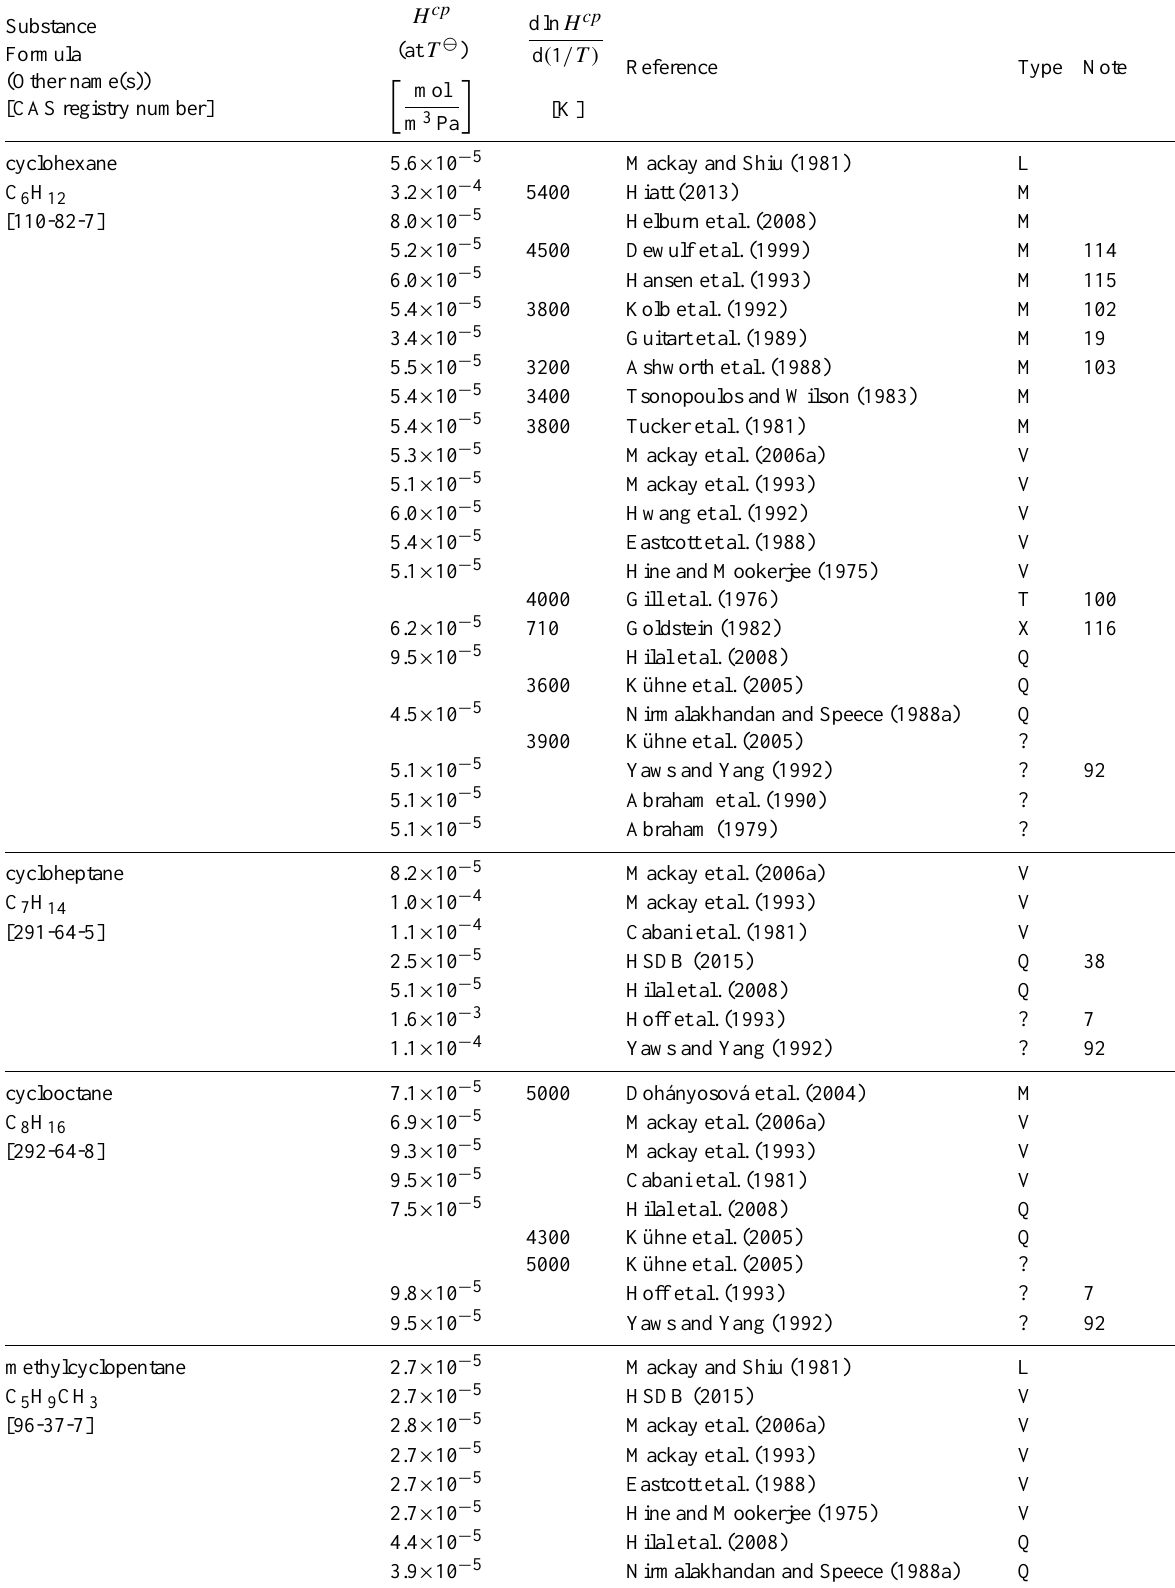
Table 6: Henry’s law constants for water as solvent